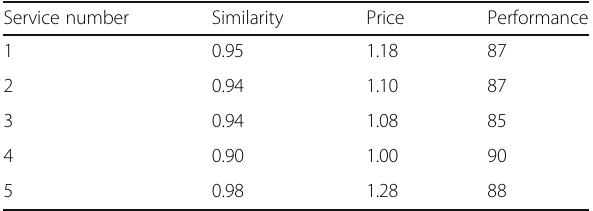
Table 2 Similarity, price and performance of 5 most similar services to a deployment entity